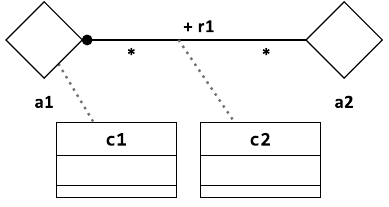
Fig. 13. Graphical representation of the association ( Assoc ) and the role ( Role )